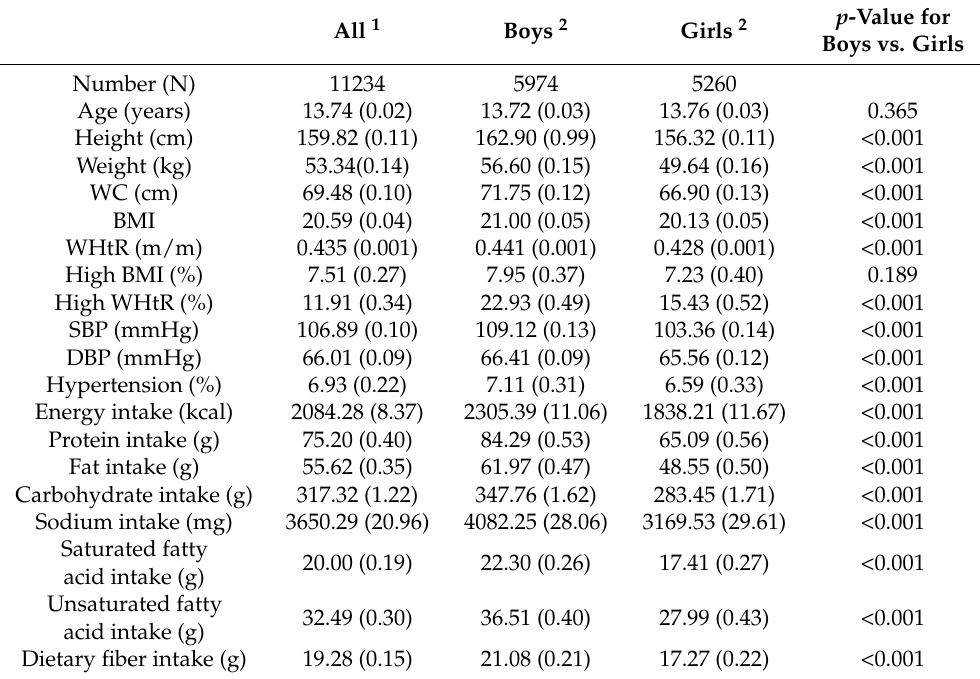
Table 1. Characteristics of the study population. Data expressed as correlation coefficient ( p -value).